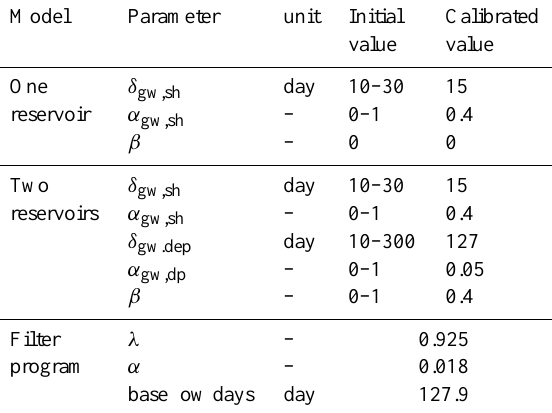
Table 1. Baseflow parameter values for one reservoir and two reser- voir approaches in SWAT and the automated baseflow filter program for the Manas River basin, Tianshan,